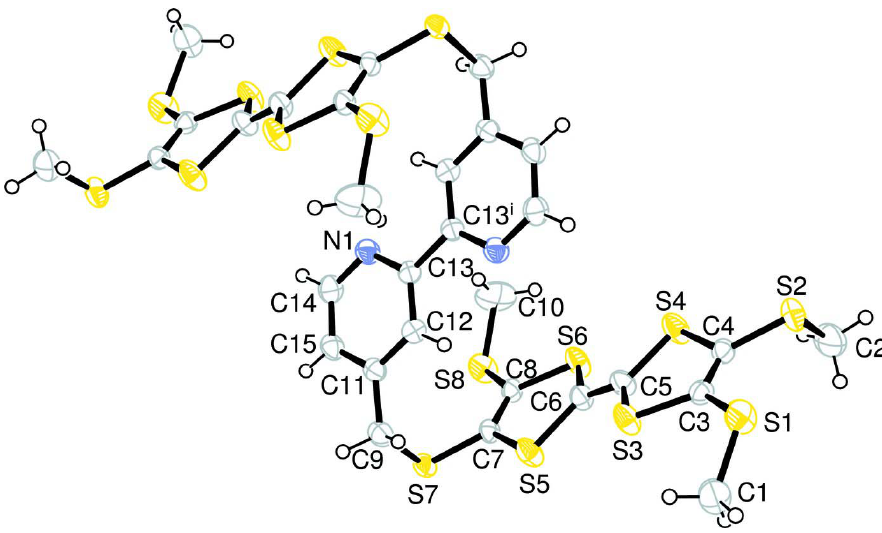
Figure 1 The molecular structure of the title compound, with atom labels and 50% probability displacement ellipsoids for non-H atoms. Symmetry code: i = -x+1, -y+1,